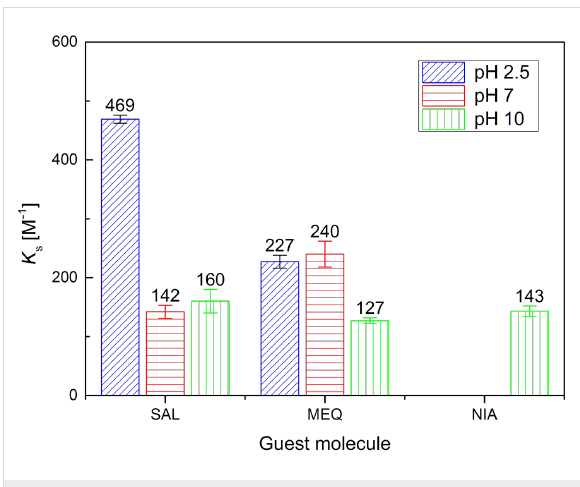
Figure 2: Stability constants for β -CD with SAL, MEQ and NIA obtained by ITC measurements.